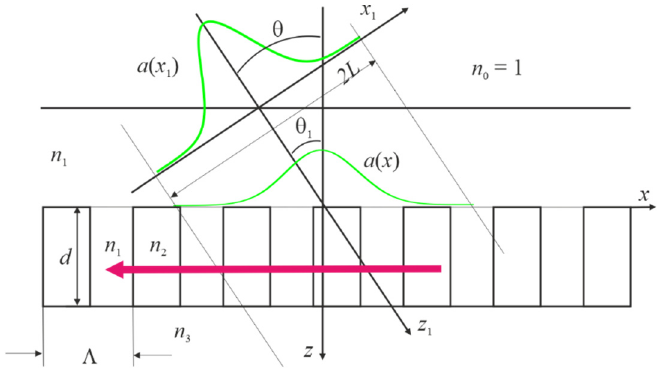
Figure 1. Incidence of the Gaussian beam on the grating. The grating parameters are as follows: Λ = 0.70 µ m, n 1 = 1.33, n 2 = 2, n 3 = 1.45, F = 0.5. The angle θ takes only two values, i.e., 0 and π /10. The wavelength λ and the grating thickness λ are variables. Red arrow represents waveguide mode propagation.